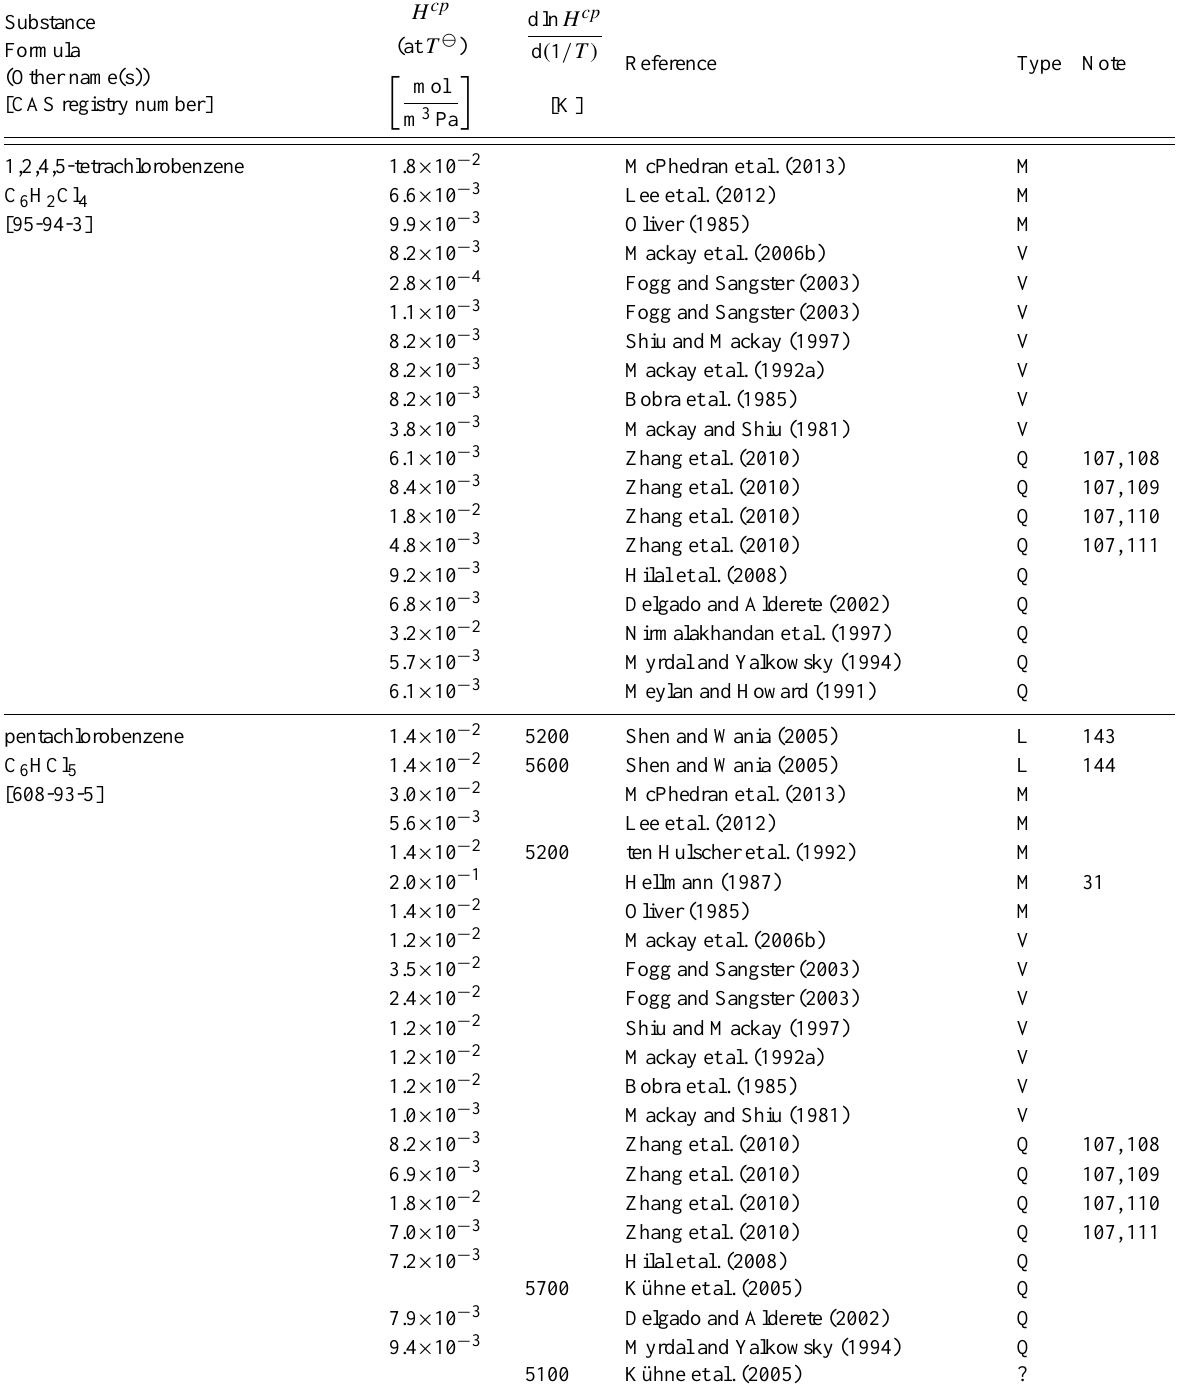
Table 6: Henry’s law constants for water as solvent